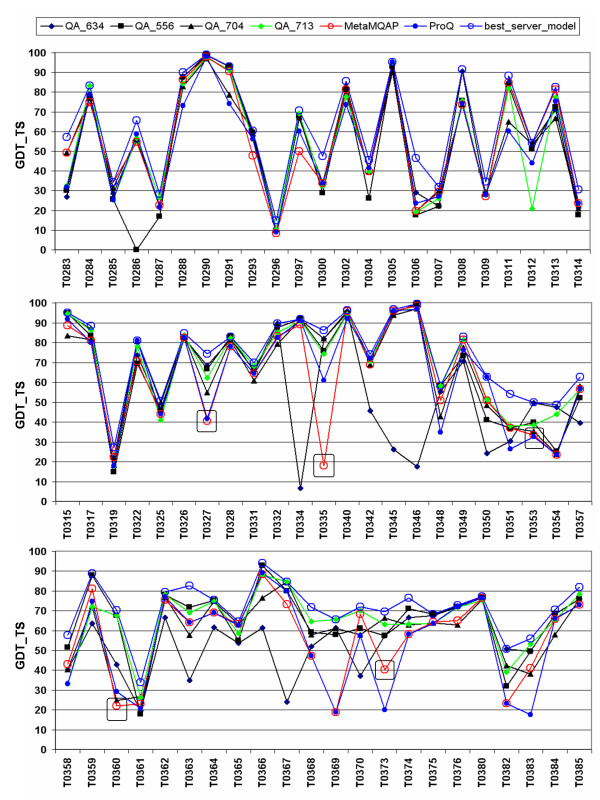
The ranking abilities of MetaMQAP compared to the best MQAP methods in CASP7 (QA_556 and QA_634, QA_713, QA_704) and ProQ, represented as the GDT_TS score of a model with the highest MQAPs ranking vs. the truly best server model for each target. Most significant mispredictions made by MetaMQAP are emphasized with red frames. This evaluation was performed on a set of all CASP7 server models.